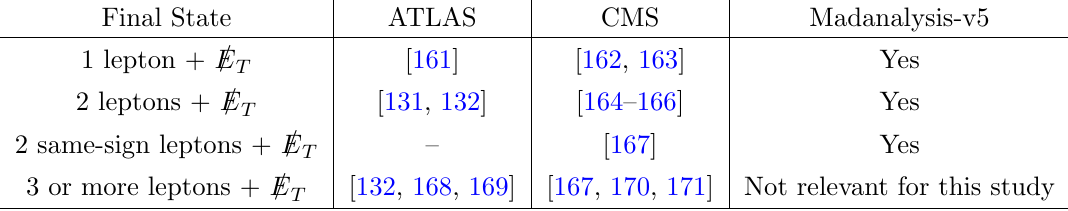
p Table 3 . Leptonic searches at s =13 TeV LHC with few jets (i,e, N j (cid:20) 2), as relevant for this